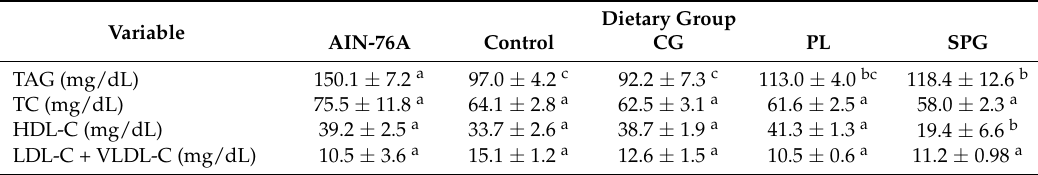
Table 5. Plasma lipid profile of SHRs consuming the AIN-76A diet and diets with a 25:1 ω -6/ ω -3 FAR for 6